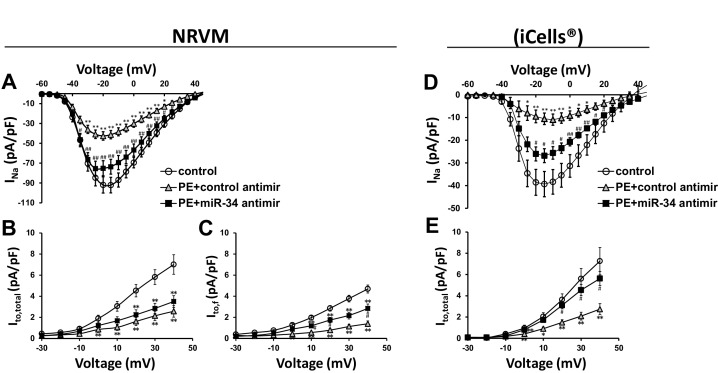
miR-34 block reverses loss of both INa and Ito in disease signaling.(A) INa I/V curve measured in NRVM transfected with either non-targeting antimirs (control, n = 26), non-targeting miR + 100 μM PE (PE+control antimir, n = 20), or miR-34b/c antimirs + 100 μM PE (PE+miR-34 antimir, n = 21) for 48 hr. (B) Ito,total I/V measurements in NRVM showing current density is lost in PE+control (n = 16) and remains down in the PE+miR-34 antimir (n = 16), compared to control (n = 17) cells. (C) Ito,f I/V measurements in NRVM. Cells treated with PE+control antimir (n = 22) have reduced current density, that is now partially restored in the PE+miR-34 antimir (n = 23) cells compared to control (n = 27). (D) I/V curve for INa taken in iCells showing that miR-34 antimirs (n = 6) can rescue current density back toward control (n = 6), when compared to PE+control (n = 6). (D) I/V curve for Ito,total measurements in iCells showing miR-34b/c antimir in the presence of PE (n = 15) can rescue current density towards control (n = 15) while PE+control (n = 15) remains reduced. Data presented as mean ± SEM. *p<0.05 versus control, **p<0.01, as indicated or compared to control antimir, #p<0.05, ##p<0.01 compared to PE+control antimir. See also Figure 6—figure supplement 1.